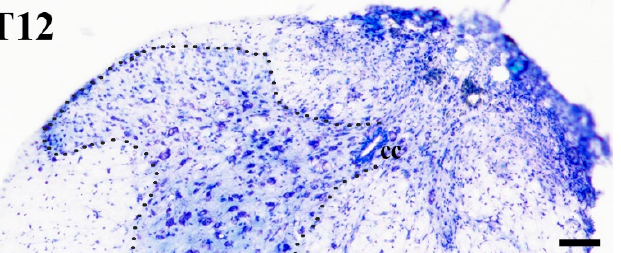
Figure 1. Hemisection of the spinal cord. Photomicrograph showing a section of the spinal cord obtained from the hemisected level and stained with cresyl violet. Note that one half of the spinal cord is intact, whereas due to hemisection, the other side does not show the normal cytoarchitectonic pattern of the spinal cord. Hemisection was performed at the Th12 level of the spinal cord. The dotted line on the intact side indicates the border between the gray and white matter. cc: central canal. Bar: 100 µm.